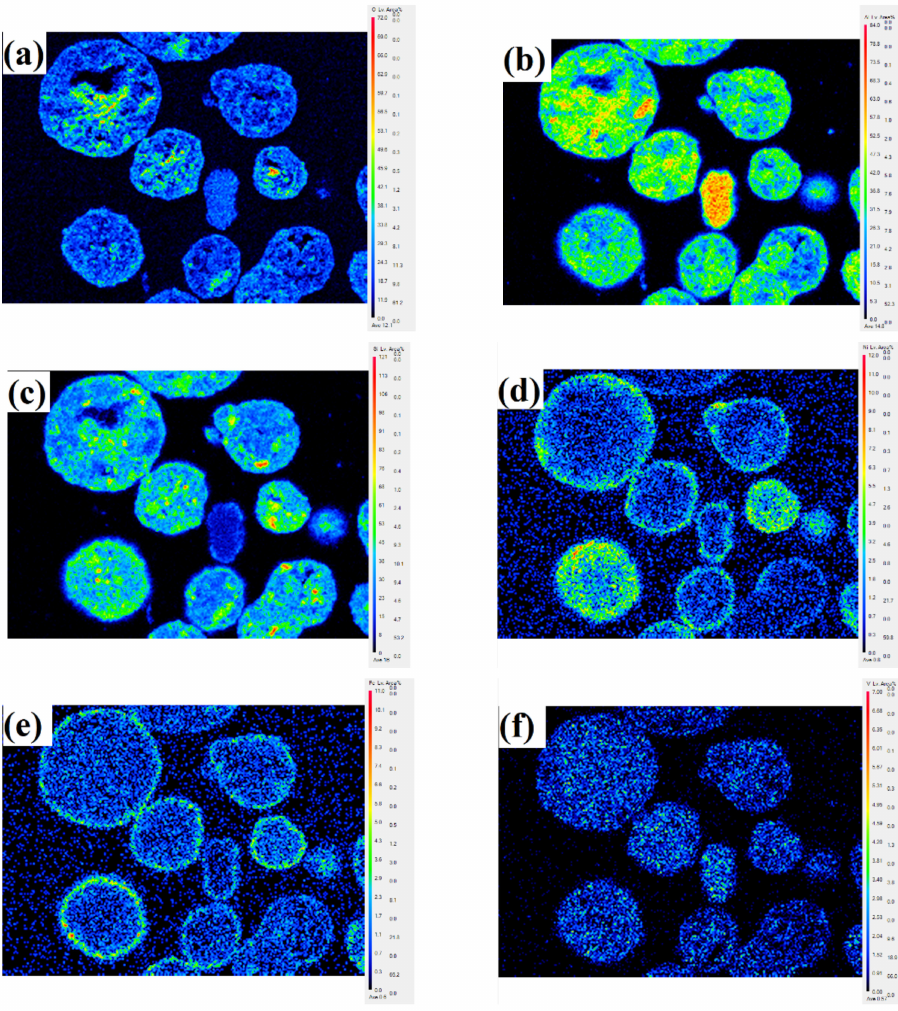
Figure 2. EPMA pictures showing the distribution of different elements in SFCC catalyst particles.